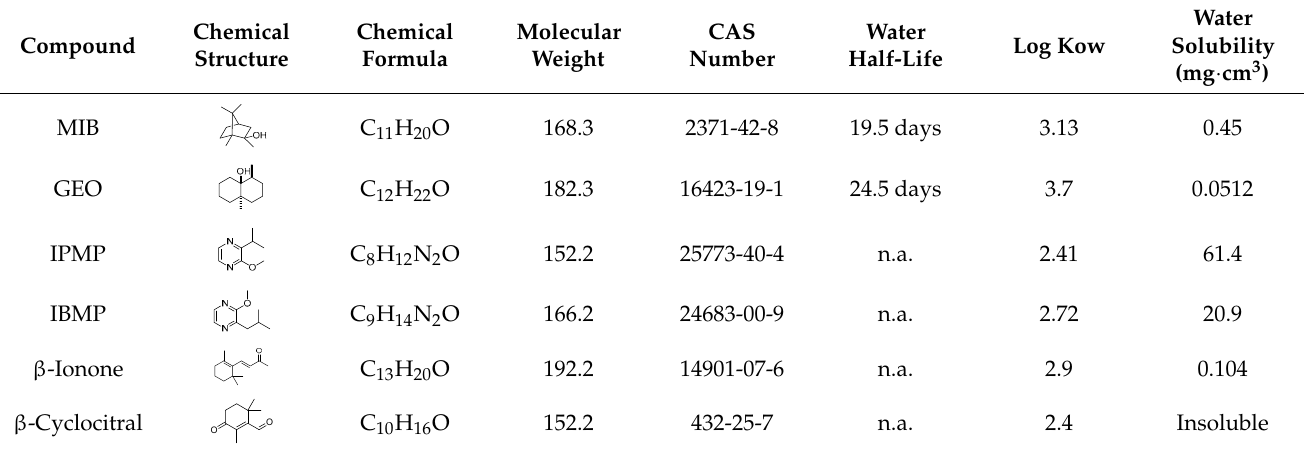
Table 1. Physico-chemical properties of main off-flavor TOCs.